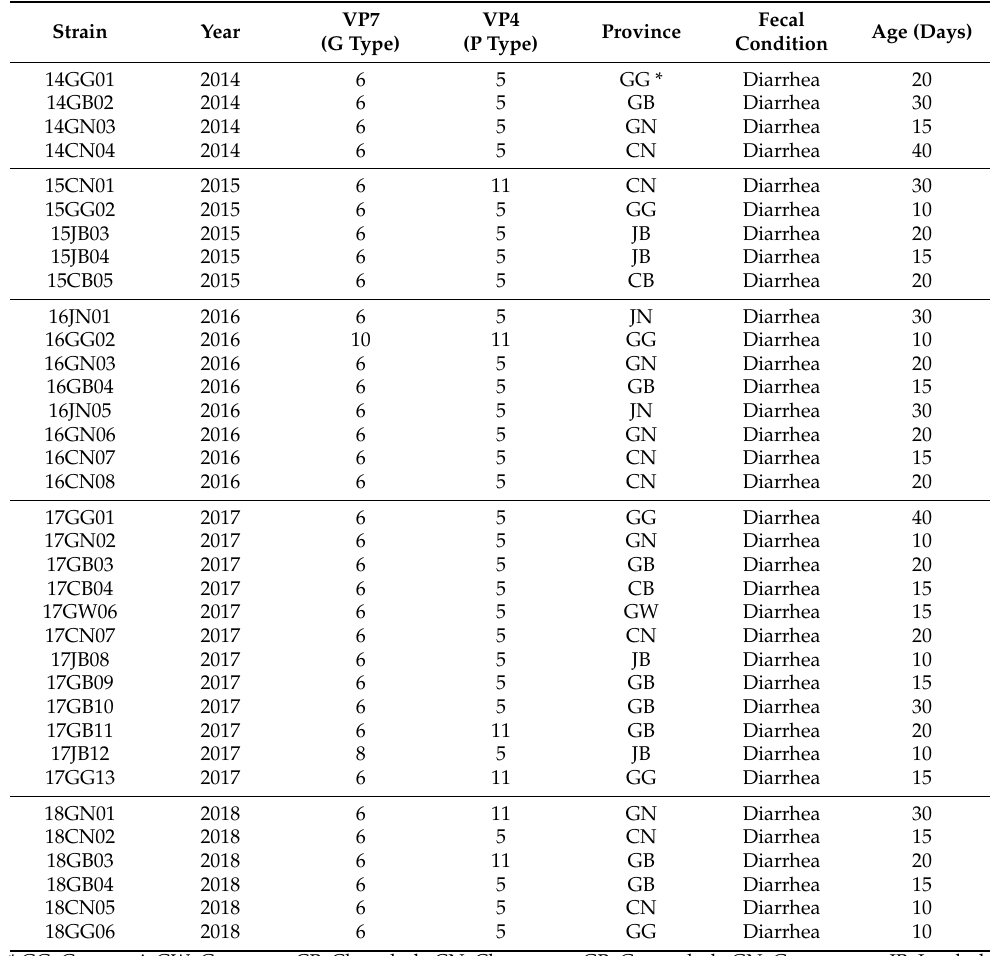
Table 2. Age, geographical region, and fecal condition of the 35 BoRVA-positive Korean calves sampled between 2014 and 2018.